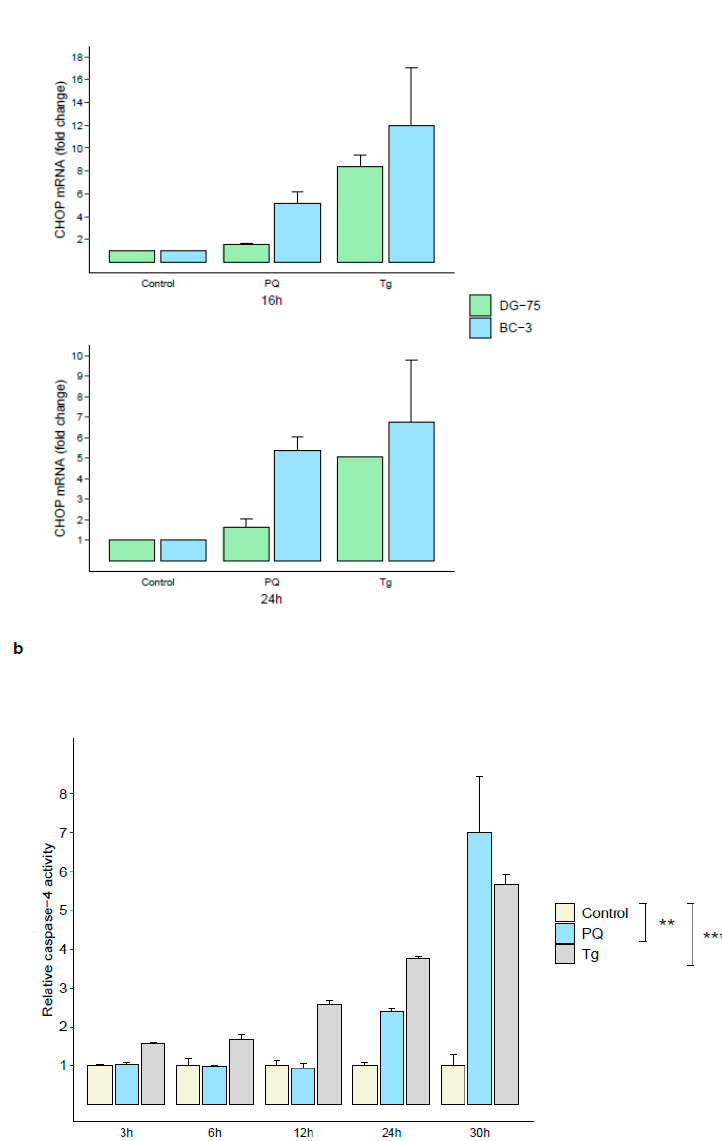
Figure 6. PQ treatment induced ER stress-mediated apoptosis in PEL cells. ( a ) Increase in CHOP mRNA level in 16 h and 24 h PQ treated-BC-3, but not in DG-75 cell lines. HHV-8-infected BC-3 cell line and HHV-8-uninfected DG-75 cell line were treated with PQ (20 µ M) or Tg (3 µ M as positive control) for 3–24 h. CHOP mRNA expression was determined by qRT-PCR and normalized to β -actin in triplicate samples. The values of the untreated control are defined as 1.0. Data are expressed as mean relative to their respective untreated control at each individual time point (fold change). Error bars represent the S.E.M for two independent experiments. ( b ) PQ induced ER-associated caspase-4 activation in BC-3 cell line. BC-3 cells were treated with PQ (10 µ M) or Tg (1 µ M as positive control) for 3–30 h followed by measurement of active caspase-4 using the fluorometric caspase-4 assay as described in Materials and Methods . The values of the untreated control are defined as 1.0. Data are expressed as mean relative to their respective untreated control at each individual time point (fold change). Error bars represent S.E.M for three independent experiments. **, p < 0.01; ***, p < 0.001 vs. untreated control (two-way ANOVA analysis and Dunnett’s multiple comparisons